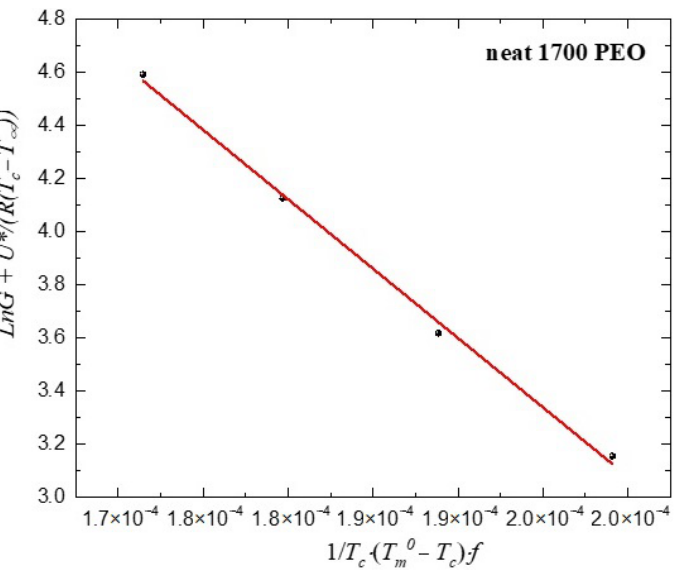
Figure A5. Spherulitic growth rate of neat PEO with M n = 1700 g/mol measured by PLOM and the data were fitted by Lauritzen−Hoffman model (the solid line).